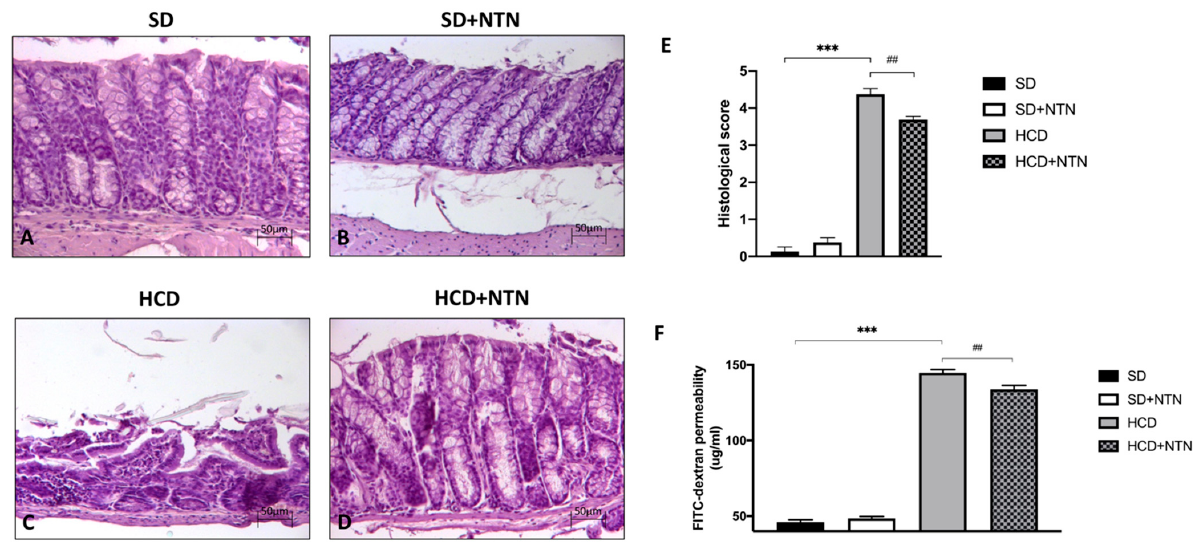
Figure 4. Effects of NTN on intestinal tissue damage and permeability in HCD mice. Neutrophil infiltration and tissue damage was observed in mice fed with HCD ( C , E ) compared to SD and SD + NTN animals ( A , B , E ). Administration of NTN was able to significantly counteract the extent of intestinal tissue damage and neutrophil infiltration in HCD mice ( D , E ). FITC-dextran permeability assay of HCD mice jejunum exposed a marked increase of intestinal permeability; NTN exerted an important protective barrier effect ( F ). Data are representative of at least three independent experiments. Values are means ± SEM. One-Way ANOVA test. *** p < 0.001 vs. SD; ## p < 0.01 vs.